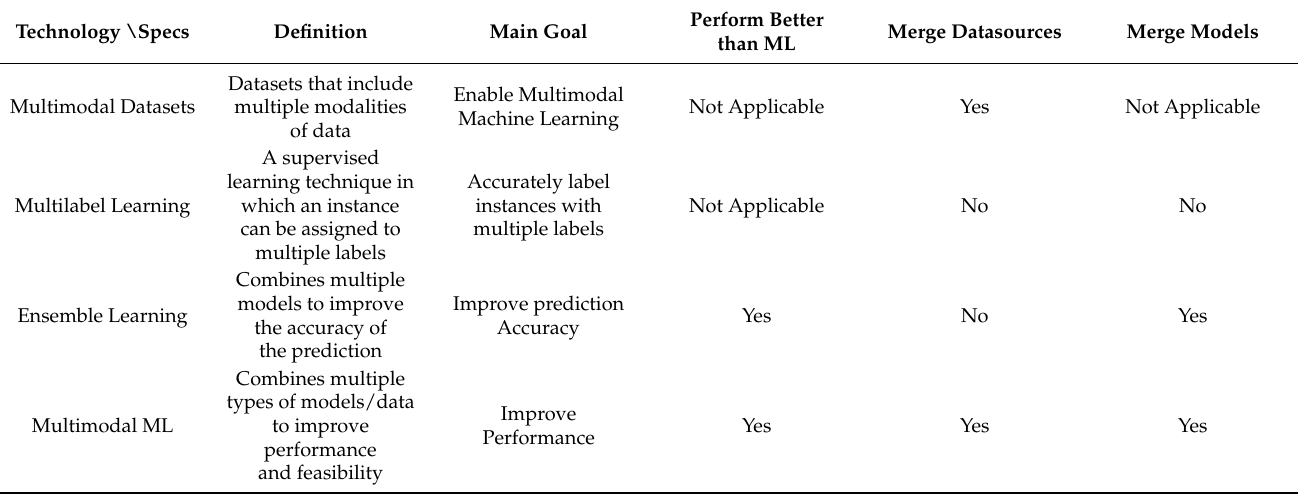
Table 3. Multimodal ML vs. other